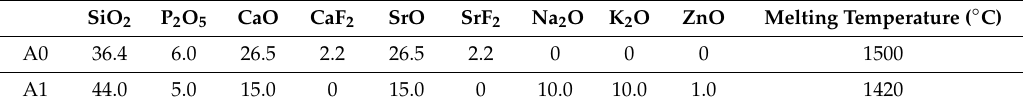
Table 1. The composition of the bioactive glass (mol.%).